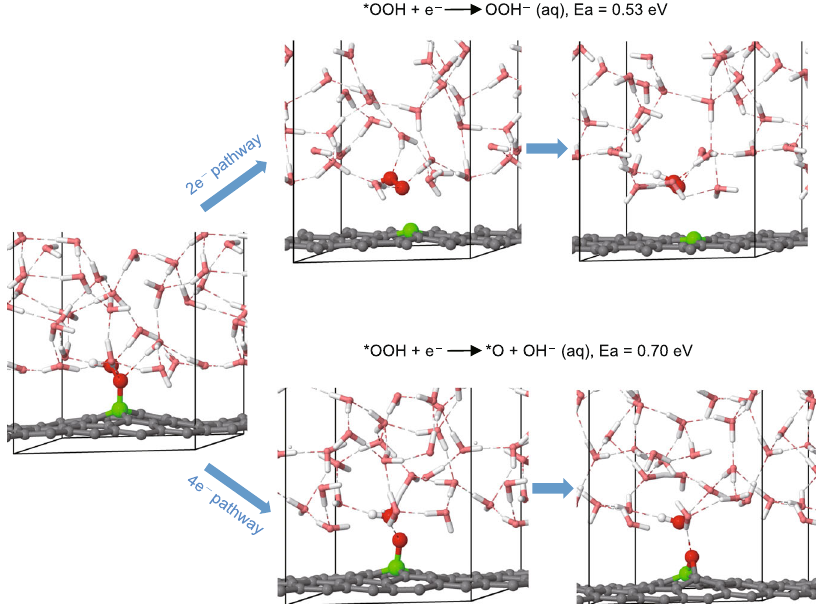
Fig. 4 Initial snapshot (left panel), highest-free-energy snapshots (middle panels) and fi nal snapshots (right panels) in our constant-potential MD simulations for both 2e − and 4e − pathways of O 2 reduction pathways. The B atom is shown in green and O atoms in *OOH are shown in red, meanwhile H atoms are shown in white and water molecules are shown in pink,